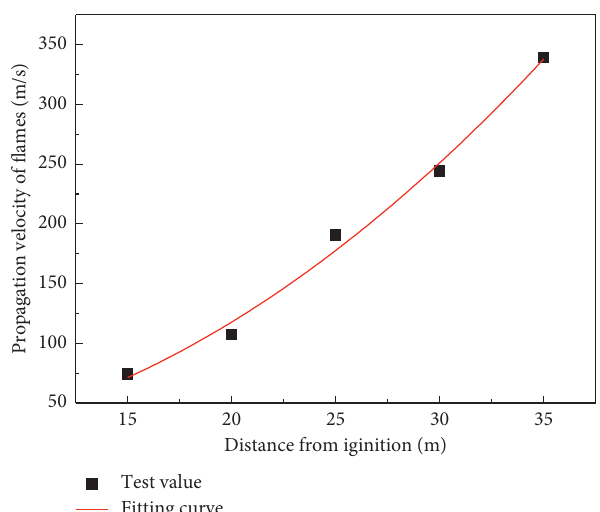
Figure 5: Average flame propagation velocities at different locations.